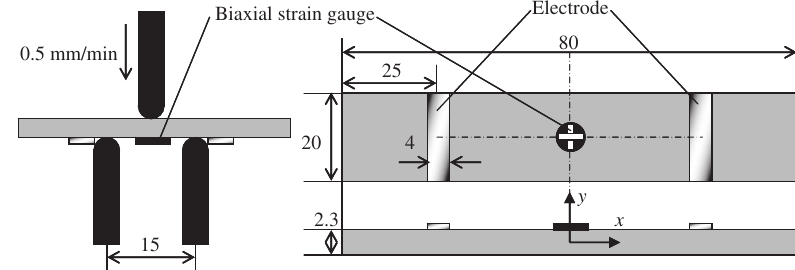
Figure 7 Experimental setup and specimen confi guration for three-point bending